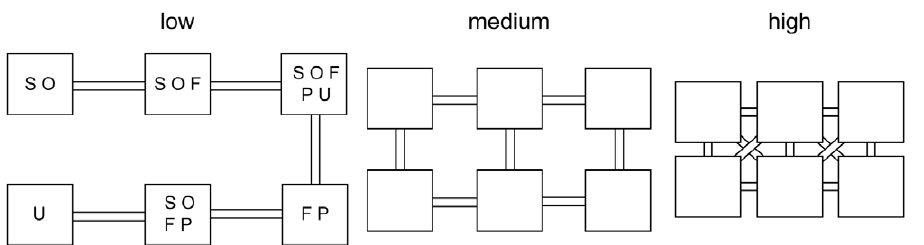
Figure 1. Experimental design and initial species distribution. Each metacommunity consisted of six microcosms that were connected according to one of three connectivity treatments, differing in the number and length of connections and in the amount of time the connections were open (low connectivity: 1 or 2 connections per basin, 15 cm length, open 4 h per week; medium connectivity: 2 or 3 connections per basin, 10 cm length, open 48 h per week; and high connectivity: 3 or 5 connections per basin, 4 cm length, 8 cm diagonales, always open). The initial species distribution was randomized and the same for all treatments, shown here in the treatment with low connectivity. S = Stylonychia , O = Onychodromopsis , F = Frontonia , P = Paramecium , and U = Urostyla.